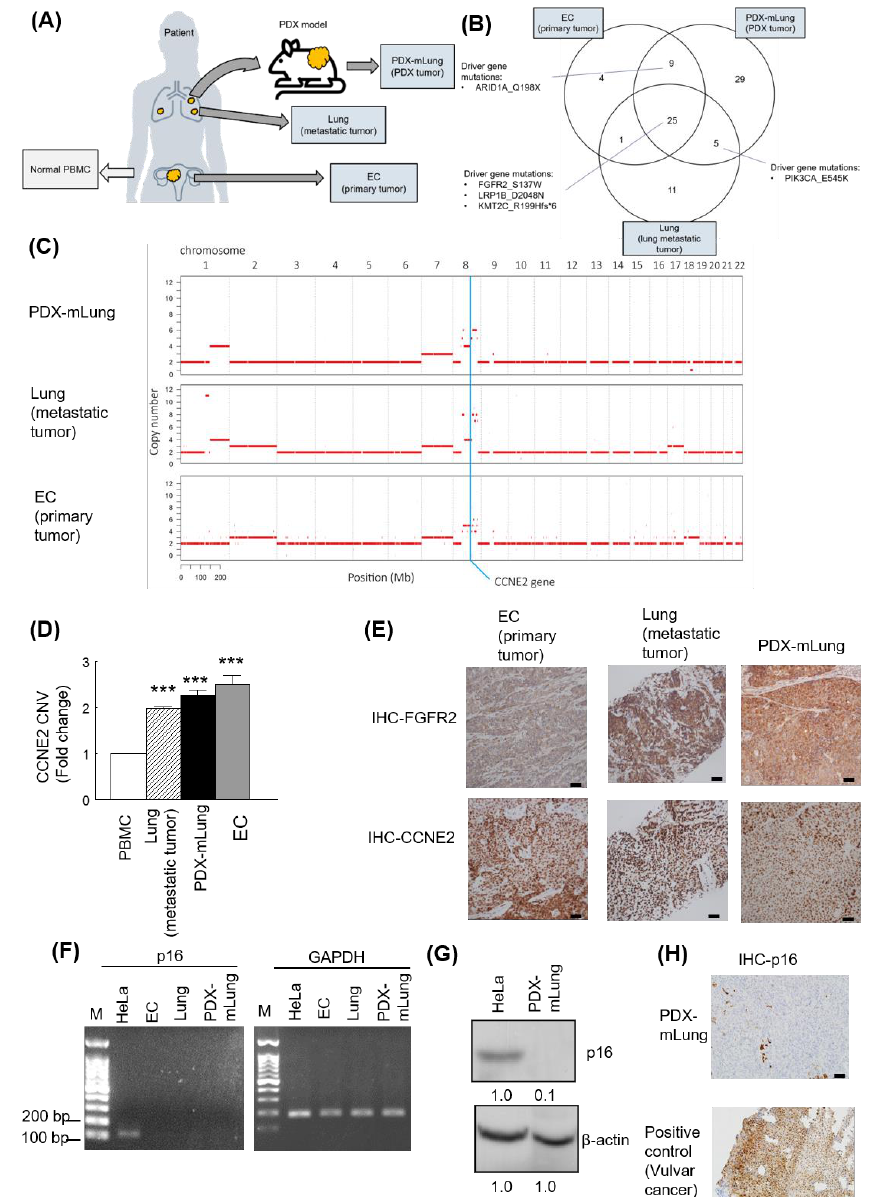
Figure 2. Experimental workflow for whole-exome sequencing (WES) in primary dedifferentiated endometrial carcinoma, lung metastasis, and PDX-mLung. ( A ) Schematic overview of sample collection. ( B ) Venn diagram of driver gene mutations identified in primary dedifferentiated endometrial carcinoma, lung metastasis, and PDX-mLung. ( C ) Comparison of copy number variations (CNVs) according to the results of WES. ( D ) Analysis of CCNE2 CNVs (qPCR) in peripheral blood mononuclear cells, primary dedifferentiated endometrial carcinoma, lung metastasis, and PDX-mLung. ( E ) Results of immunohistochemistry for FGFR2 and CCNE2 expression in primary dedifferentiated endometrial carcinoma (left panel), lung metastasis (middle panel) and PDX-mLung (right panel). ( F ) Agarose gel electrophoresis of RT-PCR products (p16 and GAPDH genes). M: 100 bp DNA marker; the size of the nucleotide ladder is indicated on the left side (100 to 200 bp). GAPDH was used as internal control. ( G ) Protein expression of p16 in HeLa and PDX-mLung, respectively. β -actin served as control for normalization. The numbers below the data mean densitometry-derived values normalized to HeLal (set to 1). β -actin served as loading control for normalization ( H ) Results of immunohistochemistry for p16 in PDX (upper panel) and vulvar carcinoma. Vulvar carcinoma specimens expressing p16 were used as positive controls (lower panel; scale bar = 50 μm).